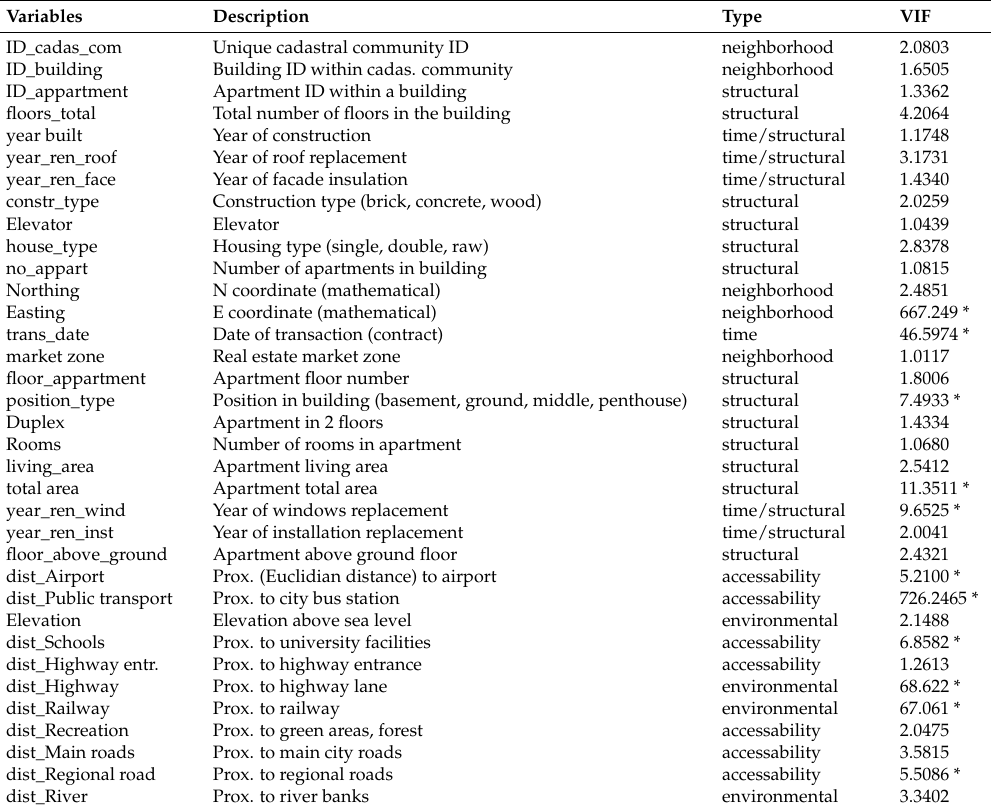
Table 1. The list of explanatory variables used in study with corresponding variance inflation factor (VIF)